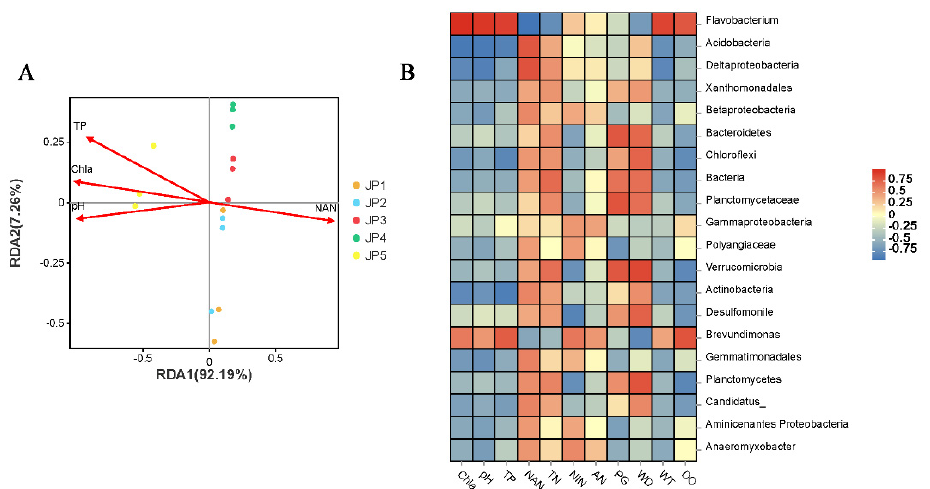
Figure 6. Correlation between physicochemical factors and microbial genera. ( A ) Redundancy analysis (RDA) depicted the relationship between the top four environmental indicators and the composition of water microbiota among five groups. ( B ) Correlation heatmap between microbial abundance and all physicochemical factors. Statistical analyses of correlations were performed using Pearson correlation